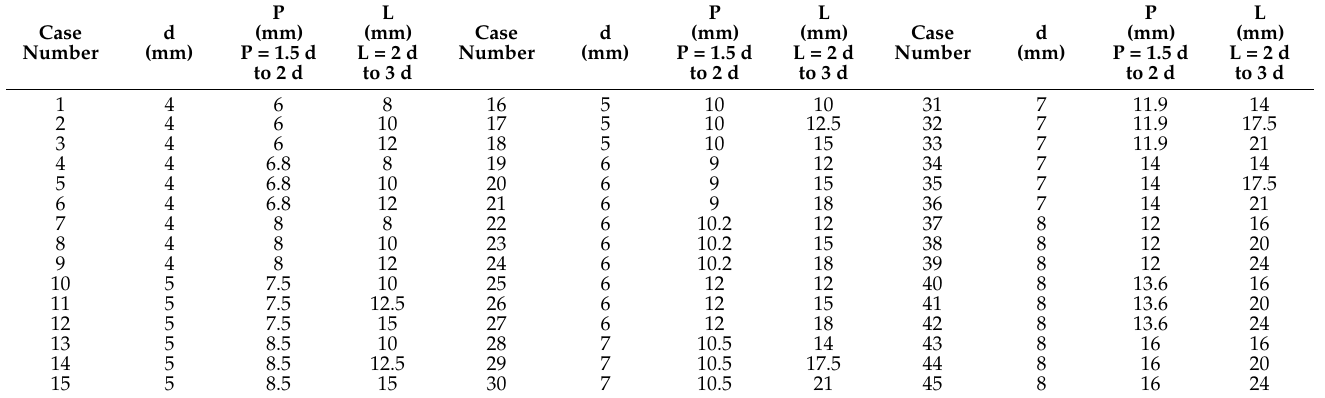
Table 1. Forty-five cases of conformal cooling channel design.